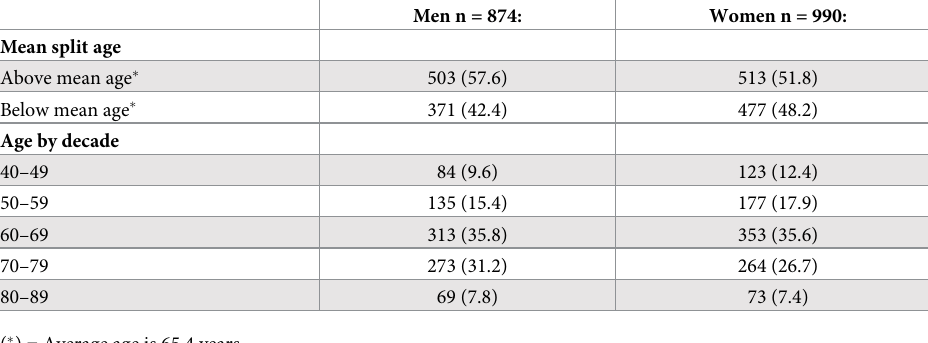
Table 1. Age distributions per sex of